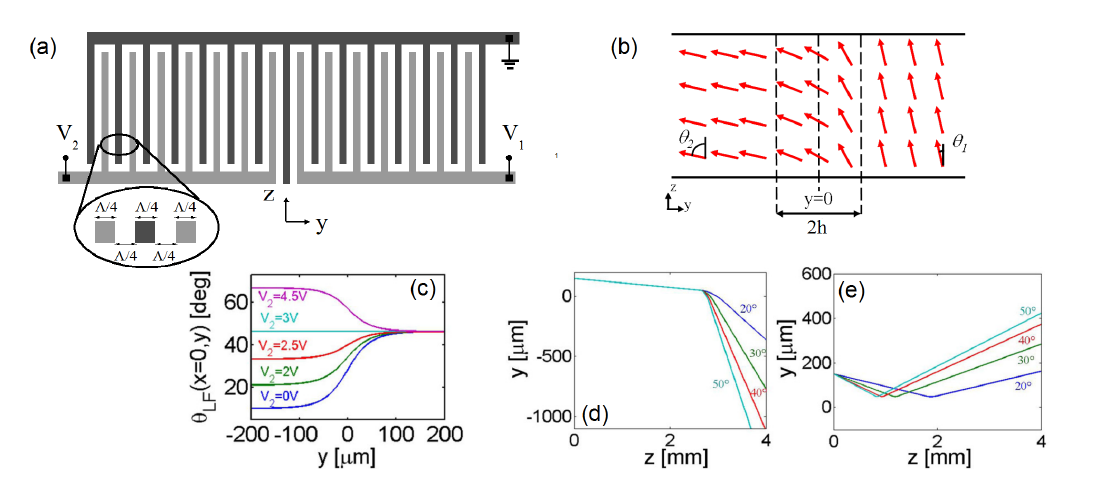
( a ) Electrode geometry and ( b ) operation of a sample with an in-plane electrically-defined graded interface; ( c ) Calculated director distribution in the cell mid-plane x = h/ 2 versus y for V = 3 V and several V . The trajectory of a soliton undergoing ( d ) 1 2 > θ = 10 (cid:14) ) and ( e ) TIR ( θ > θ = 10 (cid:14) ); in panels ( d , e ), the refraction ( θ , with θ , with θ 2 1 1 1 2 2 corresponding values assumed by θ are indicated next to each line. The interface is located 2 in y = 0